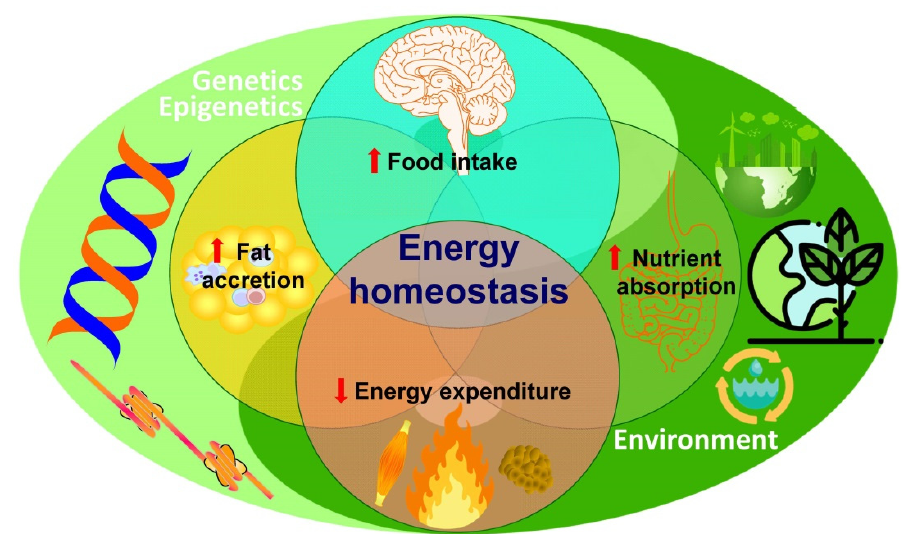
Figure 1. Schematic diagram of the factors involved in energy homeostasis. The classical Venn diagram shows how in obesity the intersection between increased food intake, nutrient absorption, and fat accumulation, together with decreased energy expenditure, the main factors determining energy homeostasis, are simultaneously under the broader influence of the environment as well as genetics and epigenetics.